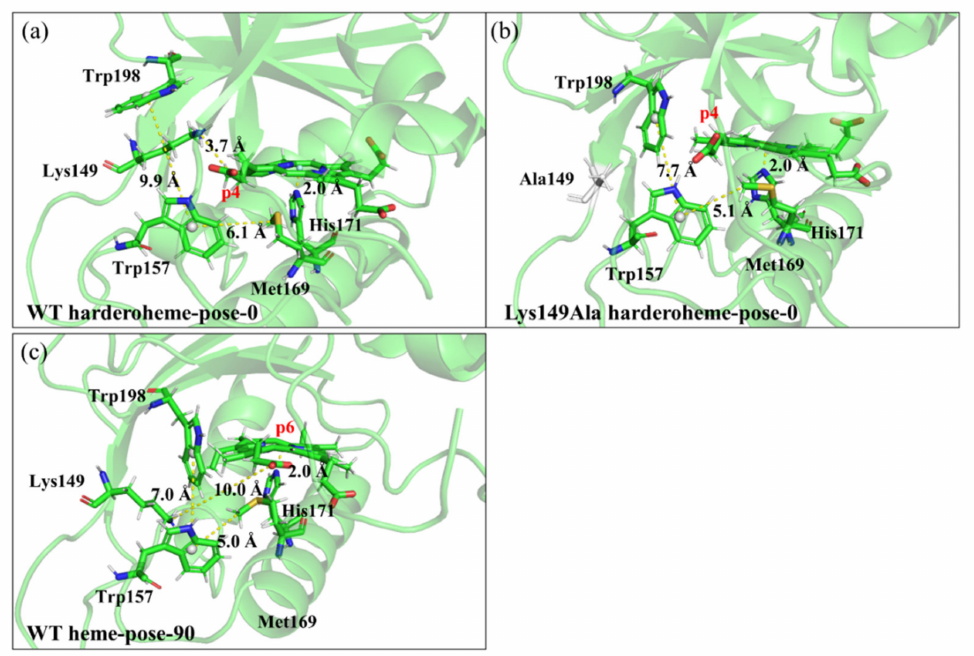
Figure 8. The structures after MD simulations of ( a ) wild-type GsChdC of harderoheme-pose-0, ( b ) Lys149Ala of harderoheme-pose-0 and ( c ) wild-type GsChdC of harderoheme-pose-90. Key distances among the Trp-Lys-Trp portal and the substrate are